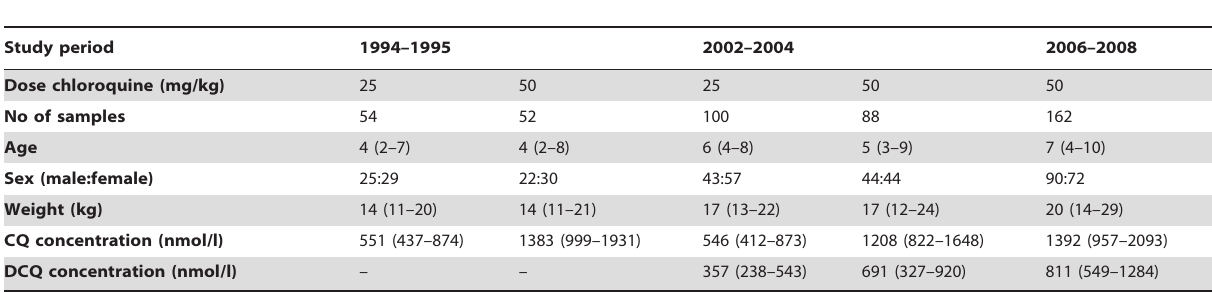
Table 1. Median age, weight and sex distribution in the different clinical